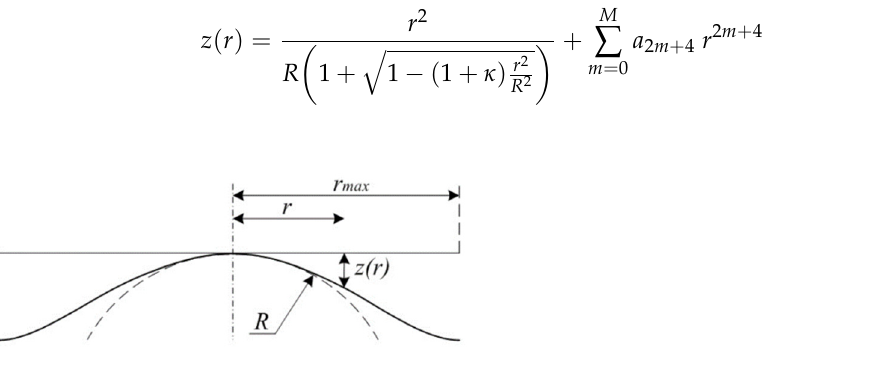
Figure 9. Description of aspherical shapes.